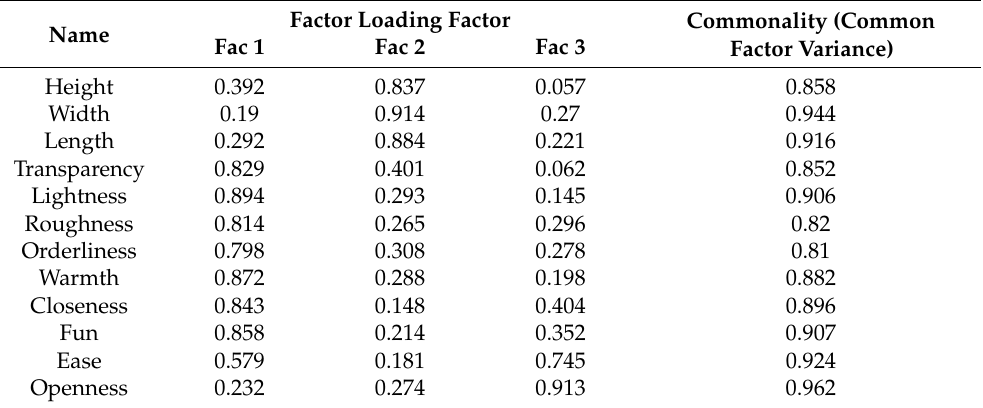
Table 6. Factor analysis